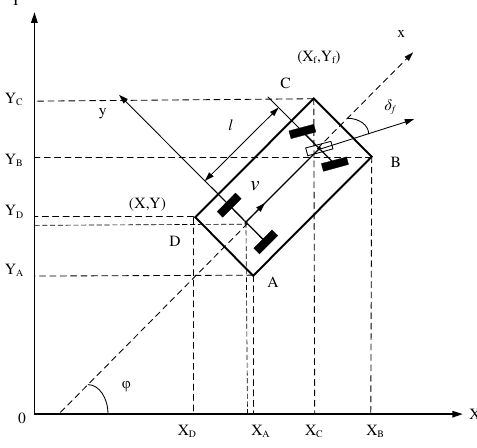
Figure 2. Vehicle kinematics model.